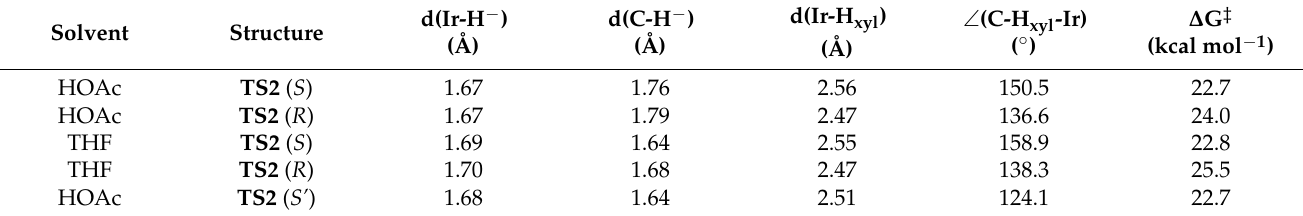
Table 1. Atomic distances, bond angles and activation energies for TS2 ( S ) and ( R ) structures, relative to their starting states in acetic acid and